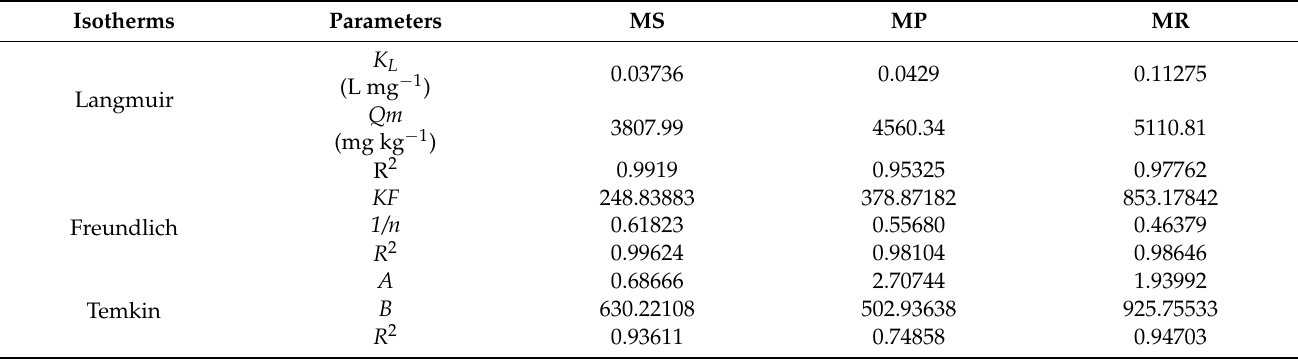
Table 3. Isotherm parameters and kinetic parameters for Fe-modified